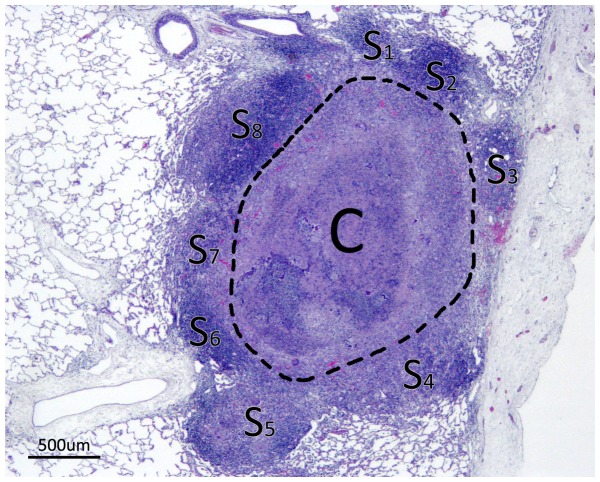
Scheme of a granuloma surrounded by satellite granulomas (SatG).Example of TB small lesion in lung consisting of a central granuloma (C) surrounded by 8 smaller SatG (S1−8) characterized by variably sized clusters of inflammatory cells contiguous to the central granuloma, sometimes with presence of MNGC and central necrosis (e.g. S5). The number of SatG, upon histopathological assessment of small granulomas, was used as a parameter to evaluate the tendency of lesions to disseminate.